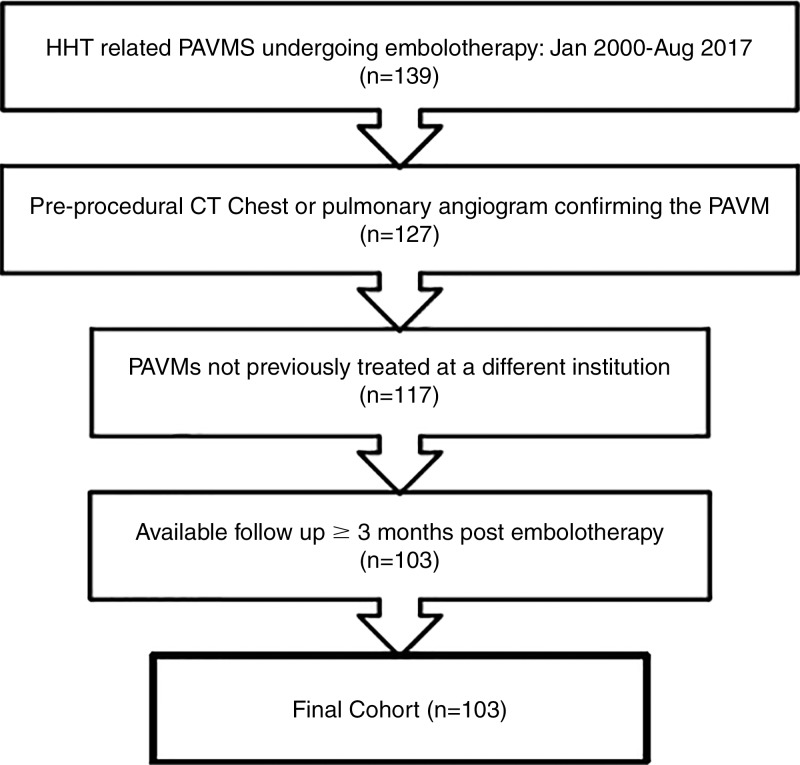
Inclusion flowchart. HHT = hereditary hemorrhagic telangiectasia, PAVM
= pulmonary arteriovenous malformation.